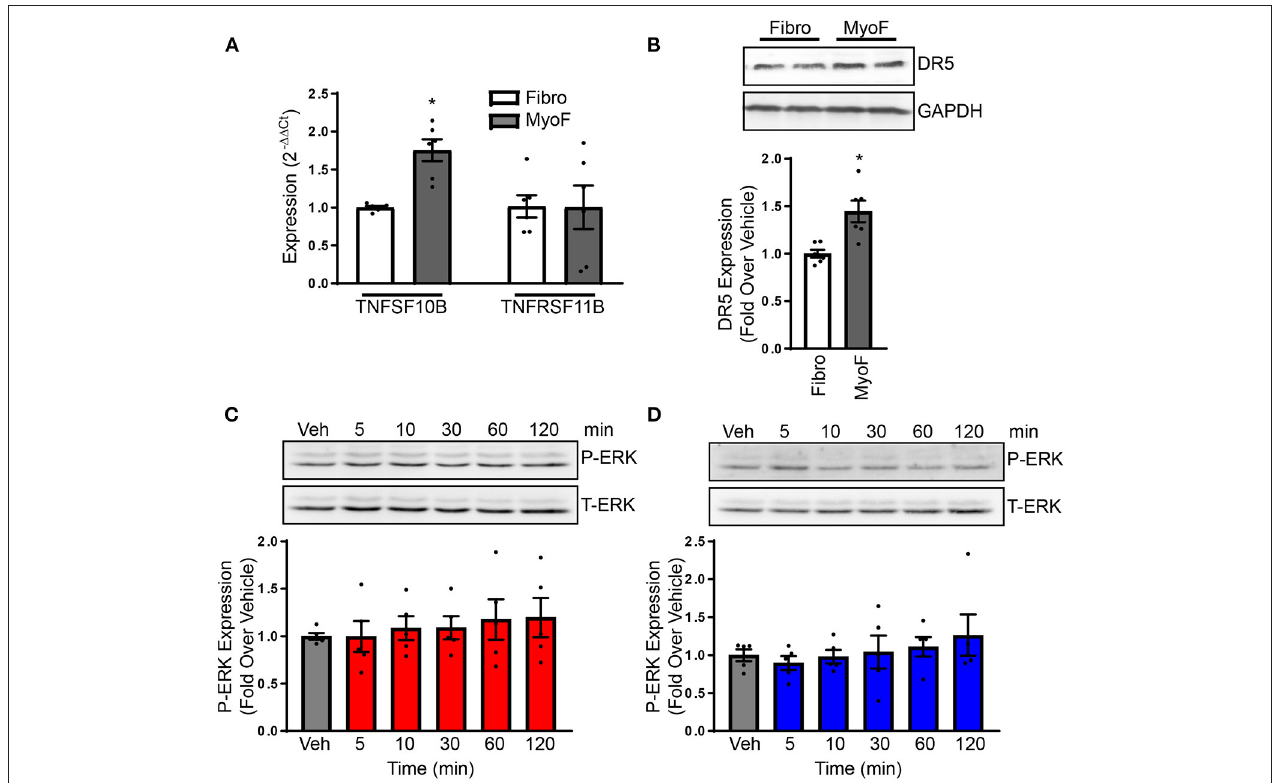
FIGURE 4 | (A) DR5 and OPG transcript expression was examined with NRVFs and myofibroblasts by RT-qPCR and expressed relative to NRVF transcript levels. n = 6. T -test, * p < 0.05. (B) DR5 protein expression was detected via immunoblot in NRVFs and myofibroblasts. GAPDH is shown as a loading control. The molecular weight ladder (Ldr) is shown in the right lane. Values are expressed relative to NRVFs. n = 6. T -test, * p < 0.05. ERK1/2 activation was examined in myofibroblasts in response to TRAIL (C) or bioymifi (D) treatment over time by immunoblot for phospho-ERK1/2. Total-ERK1/2 is shown as a loading control. n =